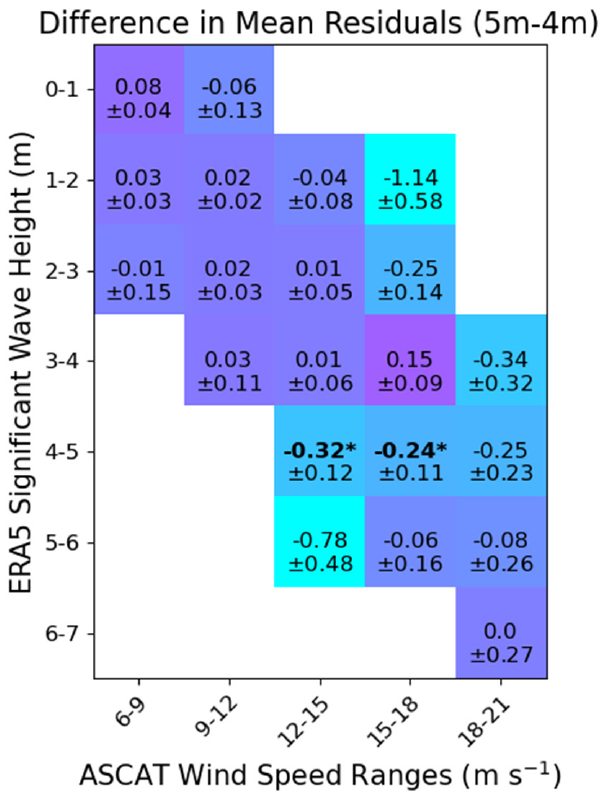
Figure 11. Heat map of the difference between the binned average of calibrated wind speed residuals (calibrated buoy U10SC–ASCAT) for ASCAT wind and ERA5 H s ranges for buoy residuals at 5 m minus the binned residuals at 4 m anemometer height in wind-wave-dominated seas ( β i > 1). Bold values with an asterisk ( ∗ ) indicate statistically significant differences between the residuals at separate anemometer heights defined using Welch’s t -test with a p -value limit of 0.05.